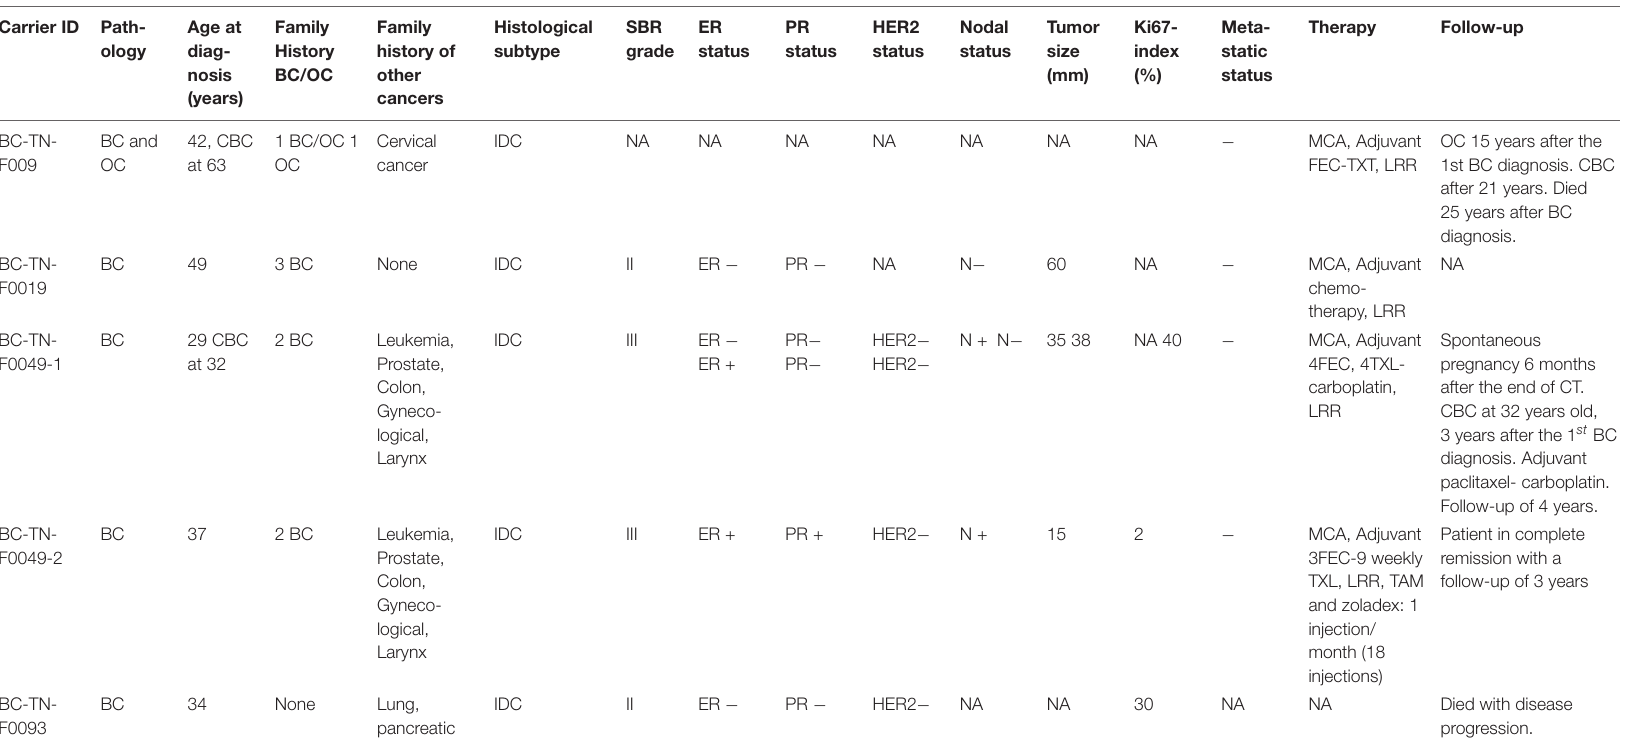
TABLE 1 | Clinico-pathological features of BRCA1 and RAD50 carriers. Carrier ID Path-